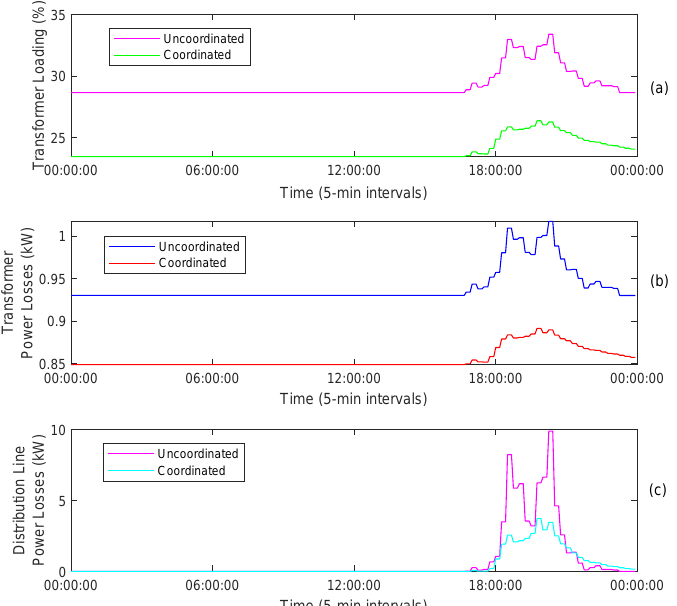
Figure 10. Transformer loading ( a ), transformer losses ( b ) and distribution line losses ( c ) for uncoor- dinated vs. proposed DCC methods without PV and BES system.